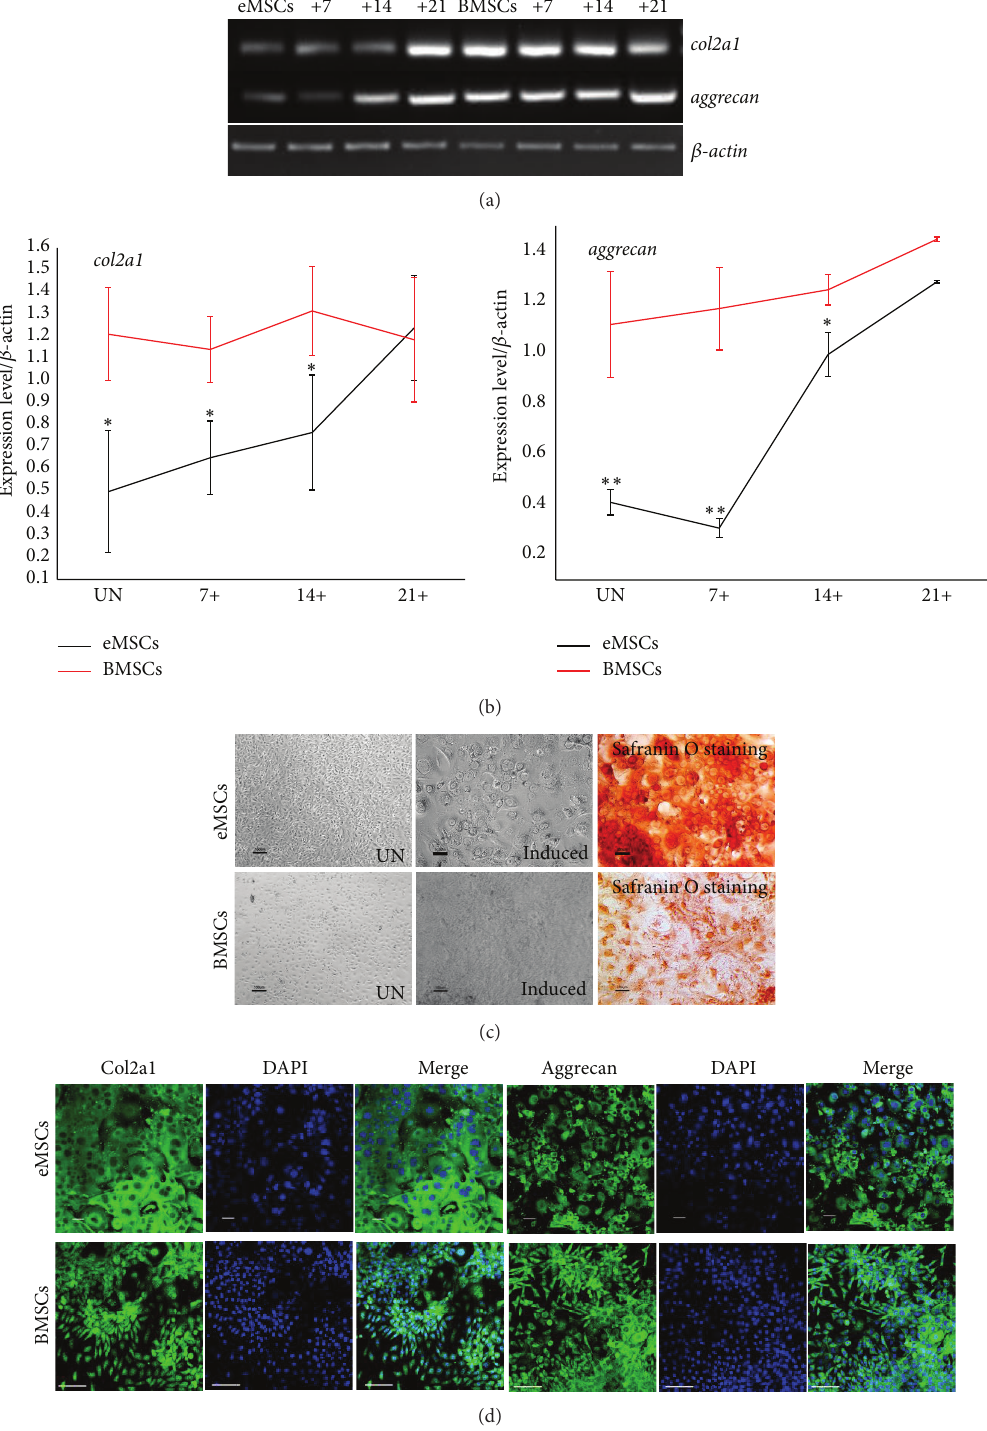
Figure 5: Chondrogenic differentiation potential of eMSCs and BMSCs. (a) RT-PCR analysis of the gene expression profiles related to chondrogenic differentiation. RNA samples from uninduced cells (UN) and induction cells (days +). (b) Semiquantitative analysis of gene expression levels by RT-PCR. RNA samples from uninduced cells (UN) and induction cells (days +). The relative expression of each gene was compared with the expression of 𝛽 -actin in the same sample. Values are the means ± SD from 3 independent experiments. ∗ 𝑃 < 0.05 , ∗∗ 𝑃 < 0.001 . (c) Micrograph of cells 21 d after chondrogenic induction. Safranin O staining (red) for negatively charged proteoglycans 21d after chondrogenic induction or uninduced cells (UN). Bars = 100 𝜇 m, (d) immunofluorescent staining for aggrecan and Col2a1, antibody staining (green), with DAPI nuclear staining